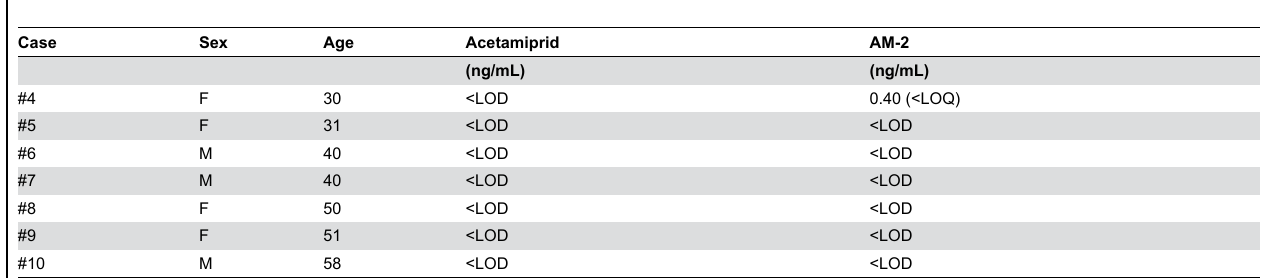
Table 2. Demographic data and the urinary levels of acetemiprid and AM-2 of the negative control group.